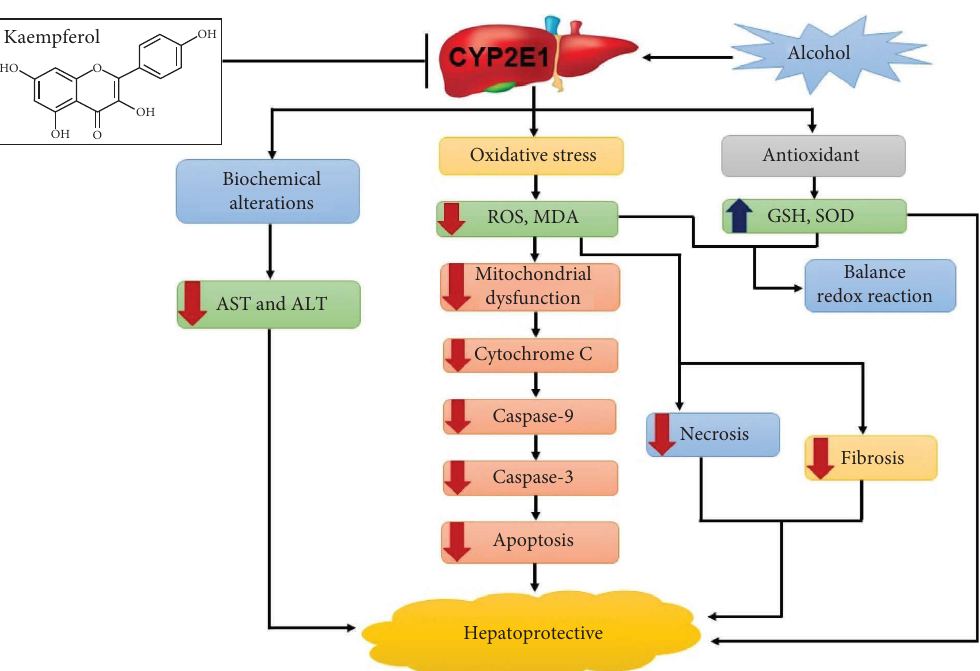
Figure 4: Kaempferol could protect the alcohol-induced hepatotoxicity by inhibiting the CYP2E1 expression and activity. Te red arrow indicates the downregulated genes, metabolites, or enzymes. Te blue arrow indicates the upregulated genes, metabolites, or enzymes. Inhibition ( ⟞